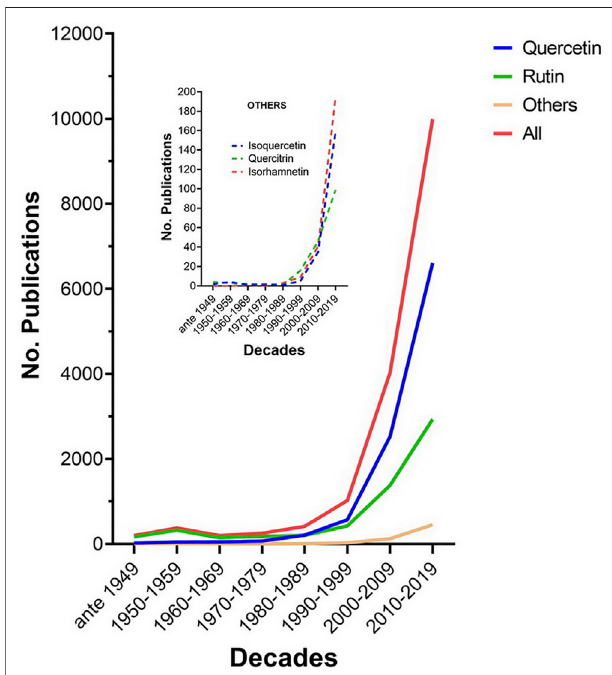
FIGURE 2 | Publications per decade on quercetin and its major derivatives. Data were retrieved from Google Scholar using as separate keywords on the title page the terms quercetin aglycone, rutin, quercitrin, isorhamnetin, and isoquercetin (or isoquercitrin or quercetin-3- glucoside). The number of hits for quercetin aglycone, rutin, other derivatives, and the sum total were classi fi ed by decade. Other derivatives include quercitrin, isoquercetin, and isorhamnetin; their hits per decade are displayed in the inset.